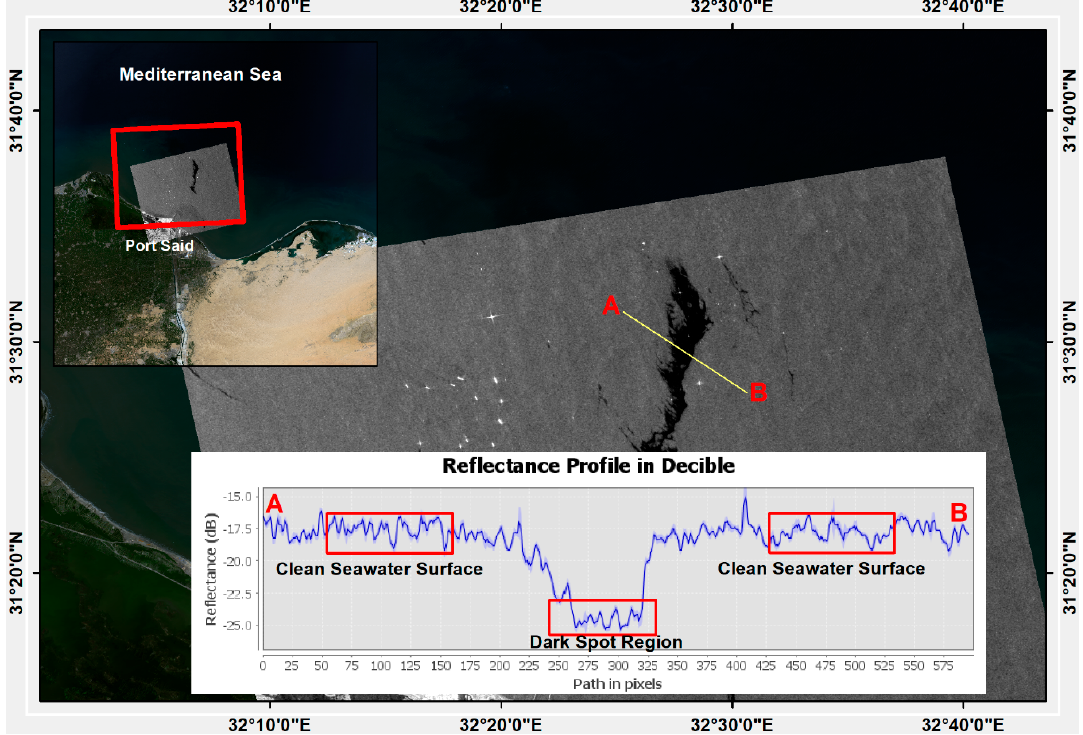
Figure 5. Oil spill clustering using a background window size of 500 pixels and a threshold shift of 3.5 dB and wind vector calculations (A= raw data; B= clustered oil spill; C= superimpose of the clustered oil spillover raw data, and; D = superimposed by wind vector layer).